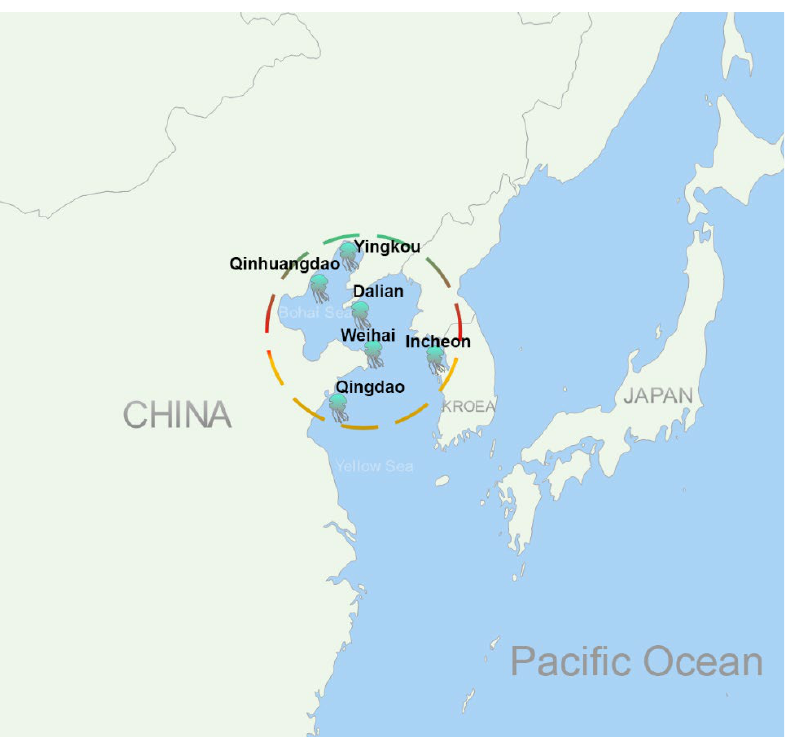
Figure 1. Distribution of death reports by jellyfish N. nomurai stings in recent years. The locations with the jellyfish symbols represent where deaths due to jellyfish stings were reported.